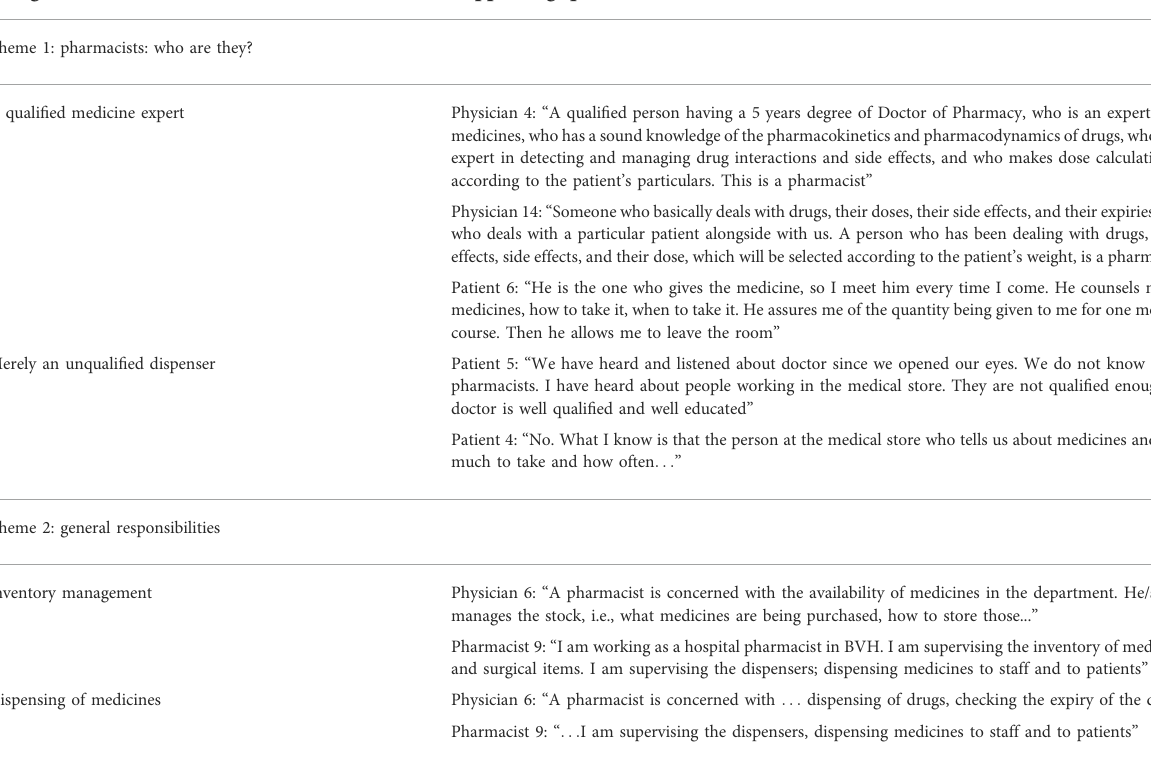
TABLE 3 Themes, categories, and supporting quotations from healthcare professionals and patients about the role of the pharmacist in TB management. Categories Supporting